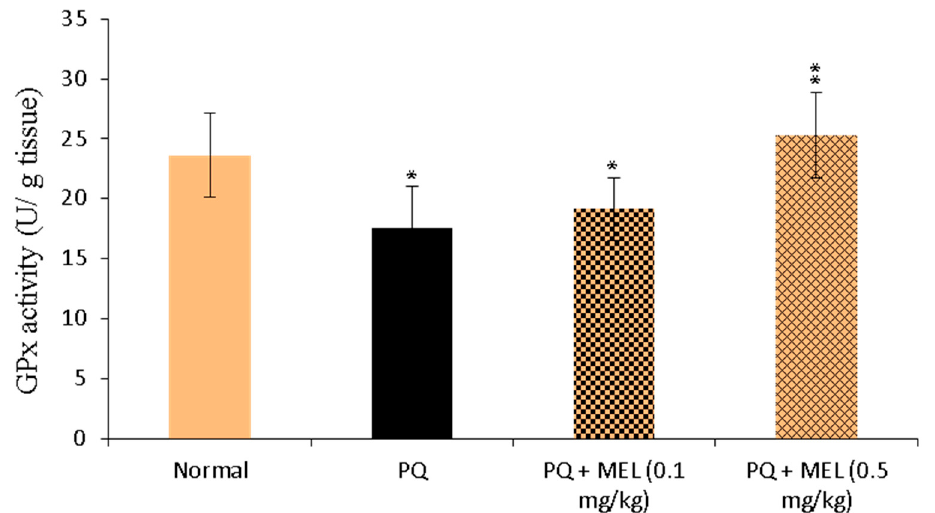
Figure 6. E ff ect of treatment with melittin (MEL) on glutathione Peroxidase (GPx) activity in lung tissue homogenate. GPx was measured in the lung tissue homogenate by UV spectroscopic method. The decrease in the absorbance was measured at 340 nm. The level of GPx was measured and expressed as U / g tissue. Data are presented as mean ± SD. Results are significantly (* p < 0.05, ** p < 0.01) di ff erent from PQ